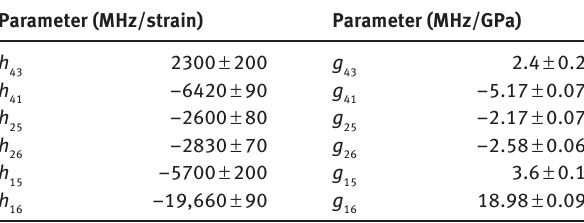
Table 2: Spin-strain ( h ) and spin-stress ( g ) coupling-strength parameters of the ground state as obtained from DFT